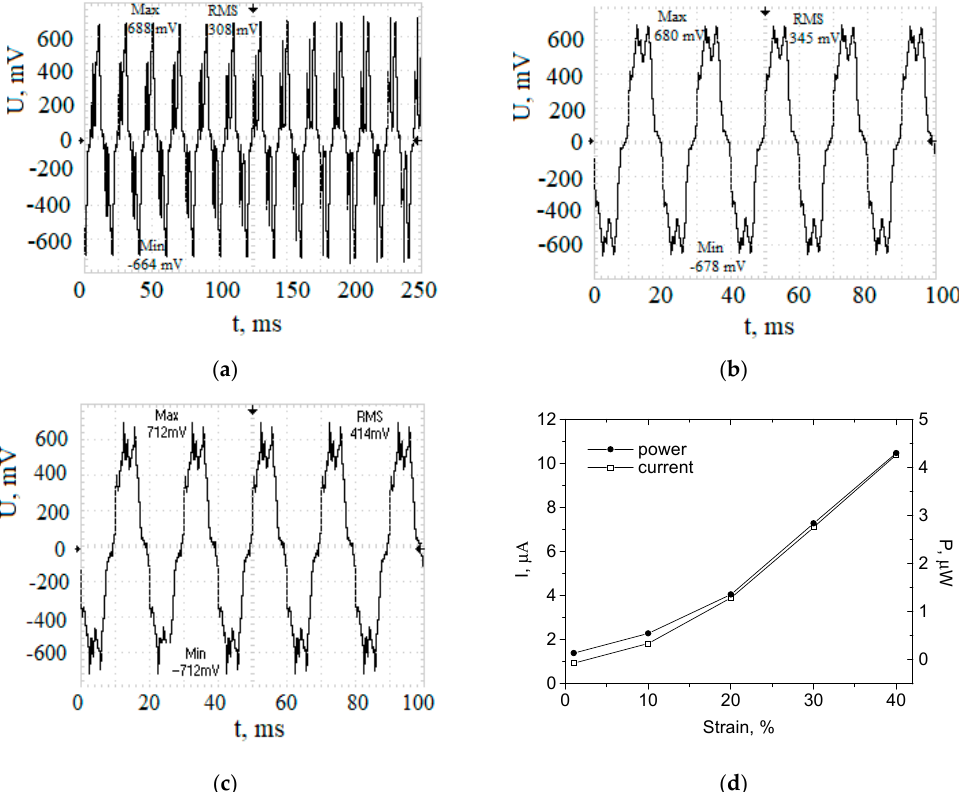
Figure 6. Piezoelectric voltage produced at a relatively low mass load of 100 g / 50Hz from Ag / ZnO:Ga 2 O 3 / Ag harvester, incorporating piezoelectric film sputtered at: ( a ) 0.5 kV; ( b ) 0.9 kV; ( c ) 1.1. kV; ( d ) current and power generated vs. strain for the structure with the optimal piezoelectric film sputtered at 1.1 kV.